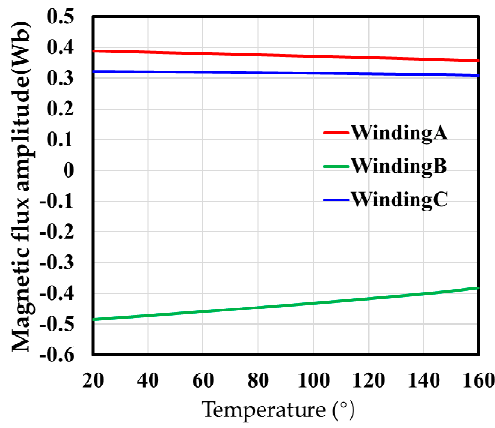
Figure 12. Magnetic flux change of the windings.